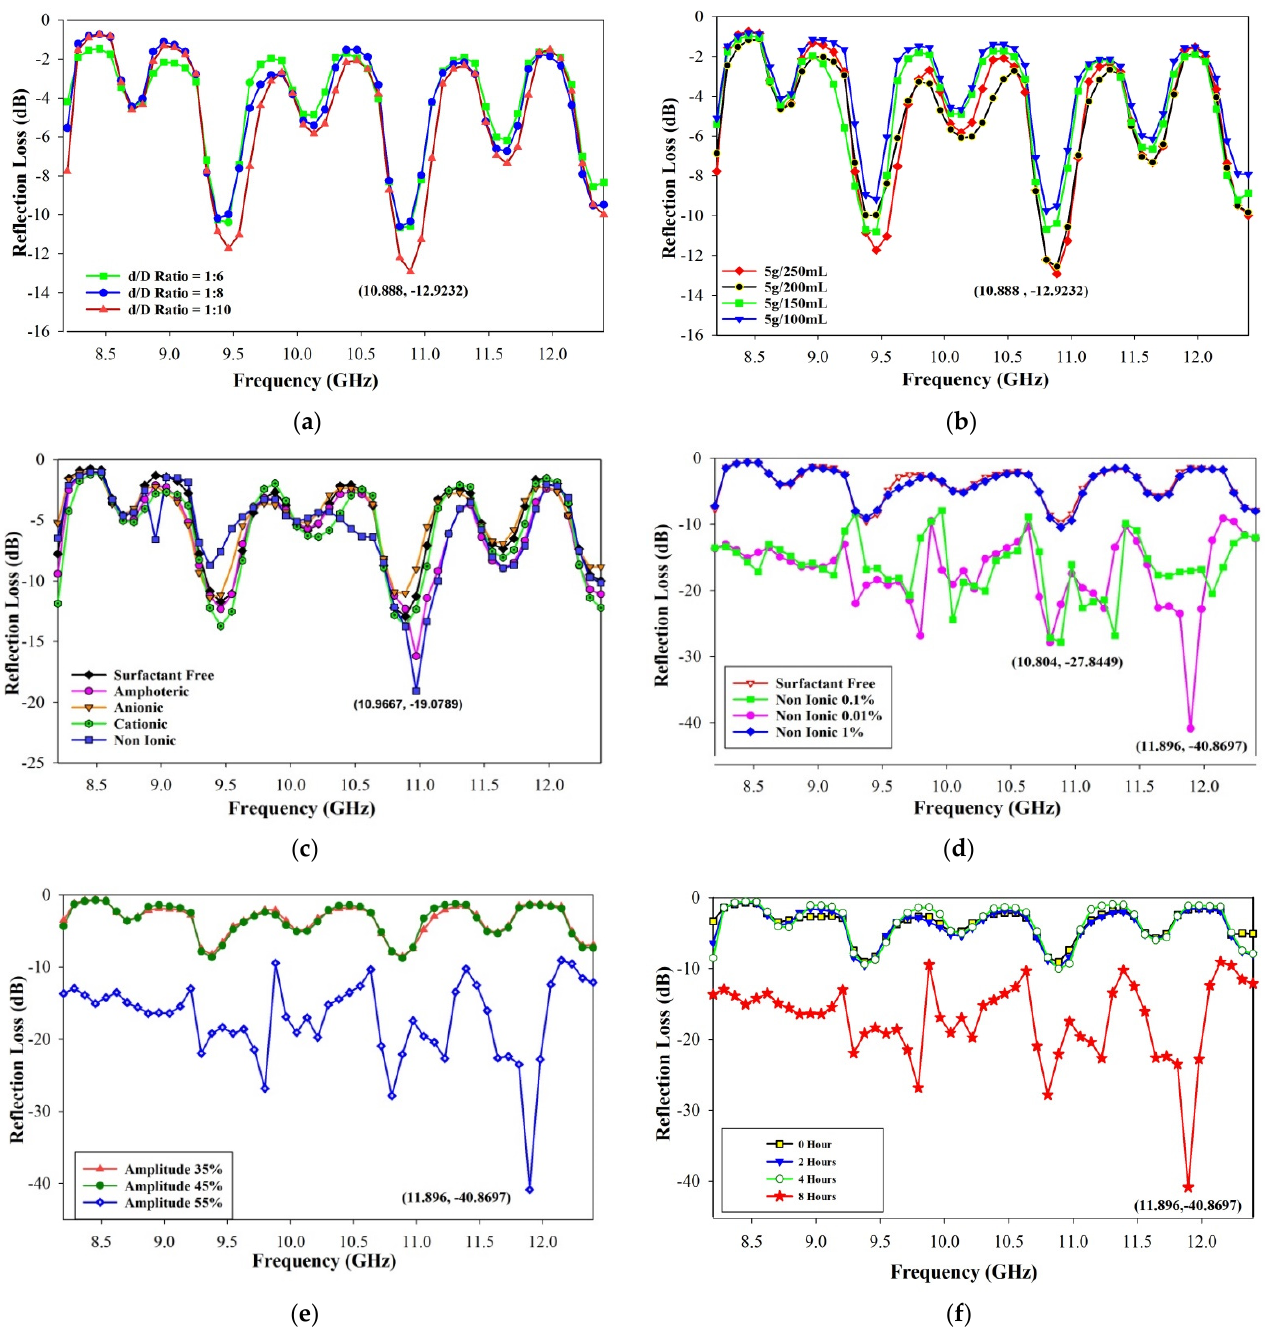
Figure 14. Reflection loss of BaFe 11.2 Mg 0.4 Al 0.4 O 19 toward ( a ) d/D ratio, ( b ) particle density, ( c ) sur- factant type, ( d ) surfactant concentration, ( e ) amplitude, and ( f ) sonication time. Figure 14d shows the reflection loss curve for variations in surfactant concentration. absorption trend equal to RL − 10.43 dB at 10.888 GHz (90% absorption). The